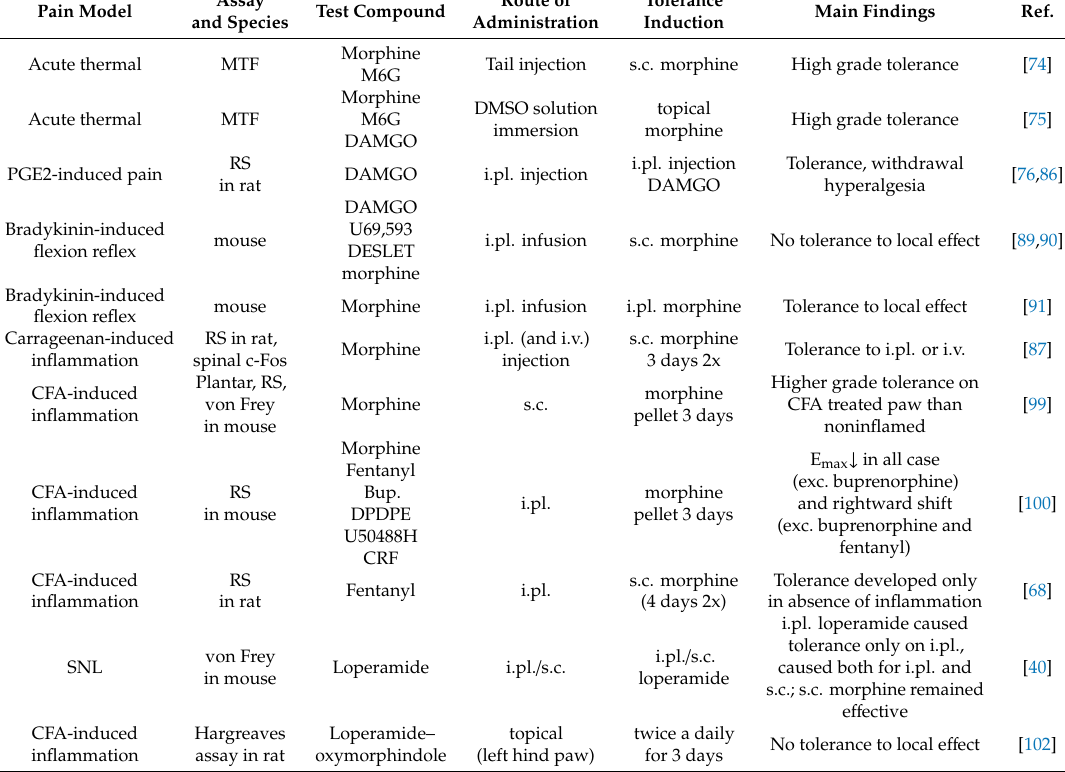
Table 2. Summary of evaluated compounds for peripheral opioid analgesic tolerance in di ff erent pain